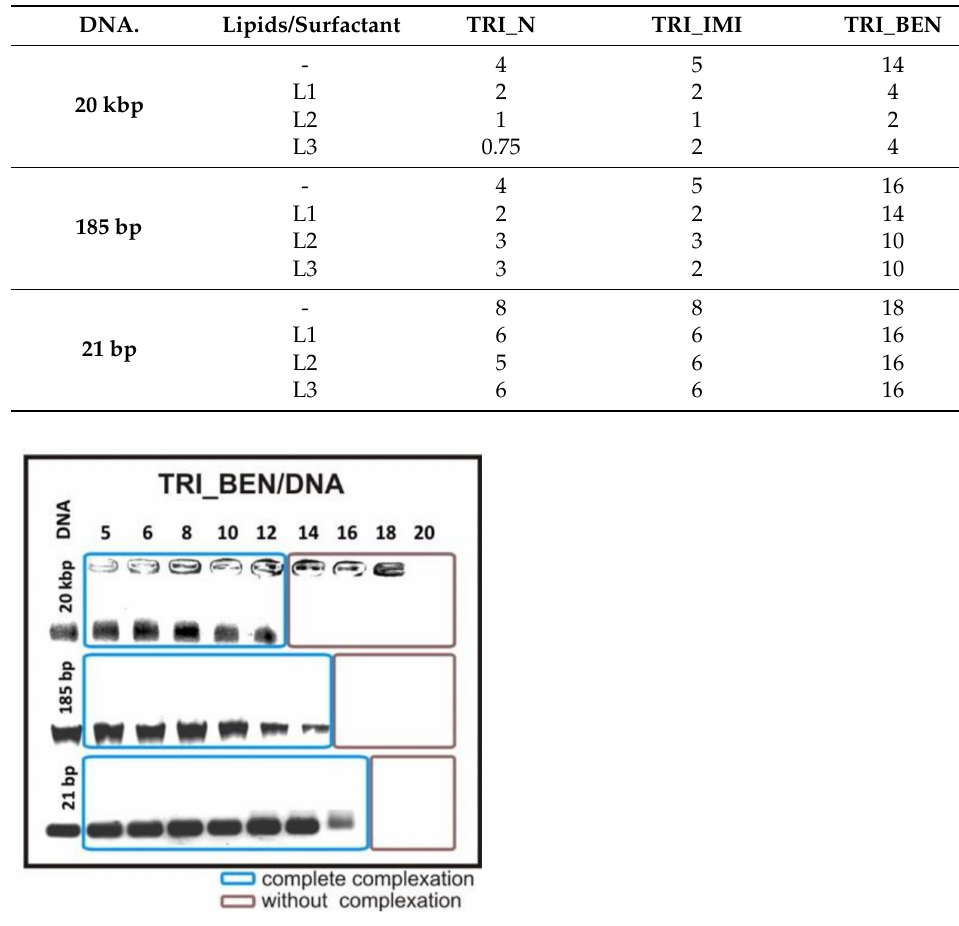
Figure 2. Agarose gel electrophoresis results obtained for lipoplexes based on TRI_BEN surfactant and all types of studied DNA